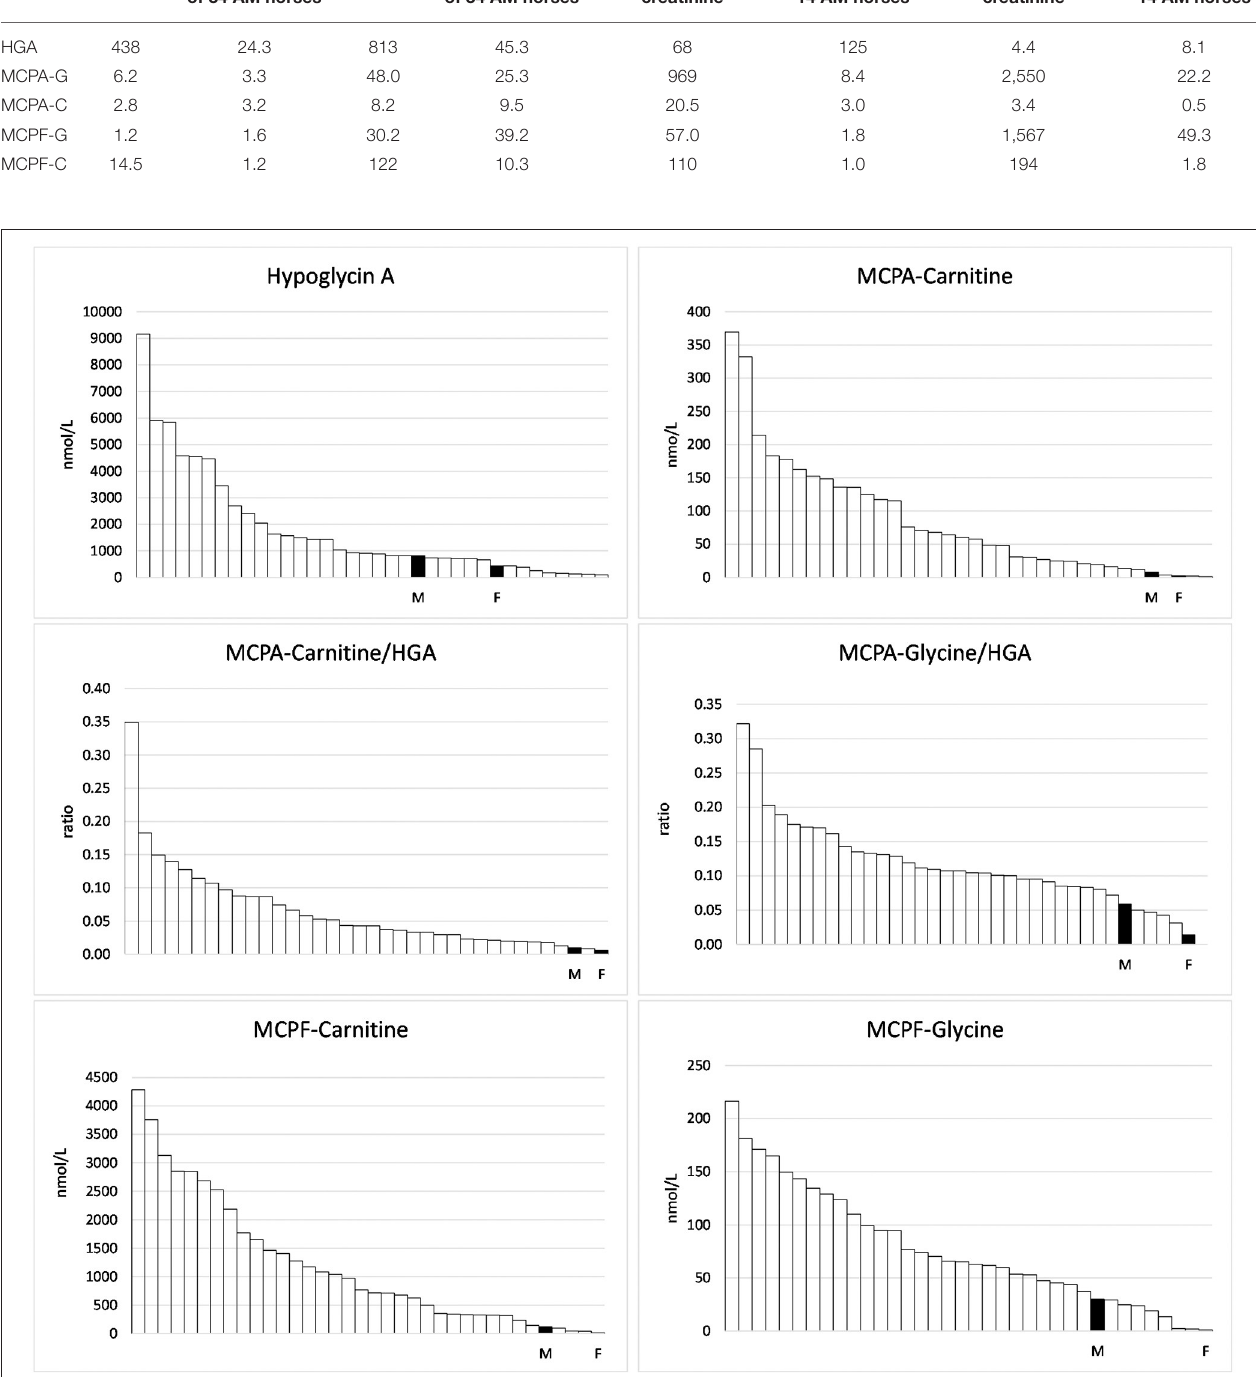
FIGURE 1 | Hypoglycin A and toxin metabolites measured in the serum of 34 horses suffering from Atypical Myopathy plus the foal (F) and the mare (M).